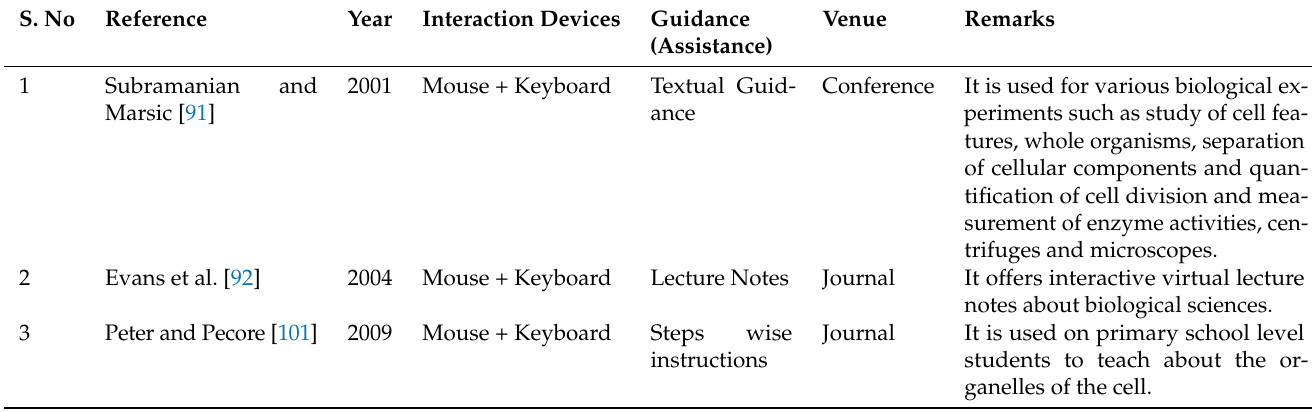
Table 3. Analysis of the existing interactive biological laboratories in